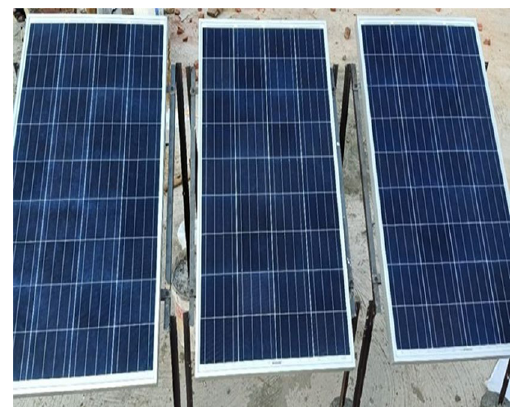
Figure 1. The Pv